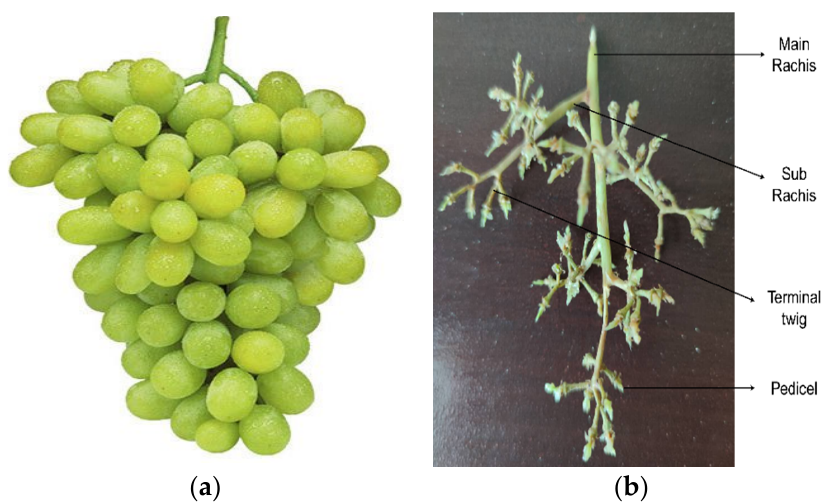
Figure 1. Structure of table grape cluster with and without berries. ( a ) Table grape cluster; ( b ) stalk fruit structure.